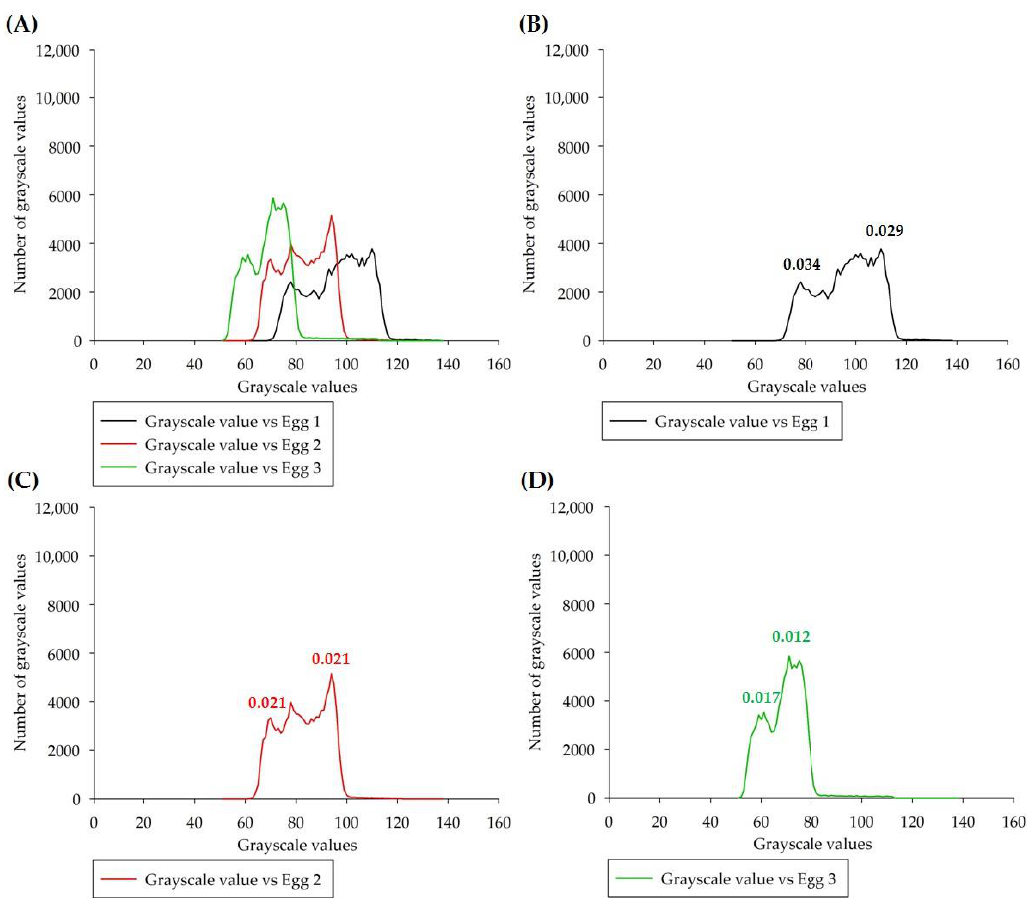
Figure 10. The results of the gray-scale density distribution curves from radiography visualization for the yolk and albumen of eggs of three different qualities in the axial plane directions. ( A ) Comparison of shell quality curves of eggs of three different qualities, ( B ) SO egg (Egg 1) (black line), ( C ) GO egg (Egg 2) (red line), and ( D ) CO egg (Egg 3) (green line).